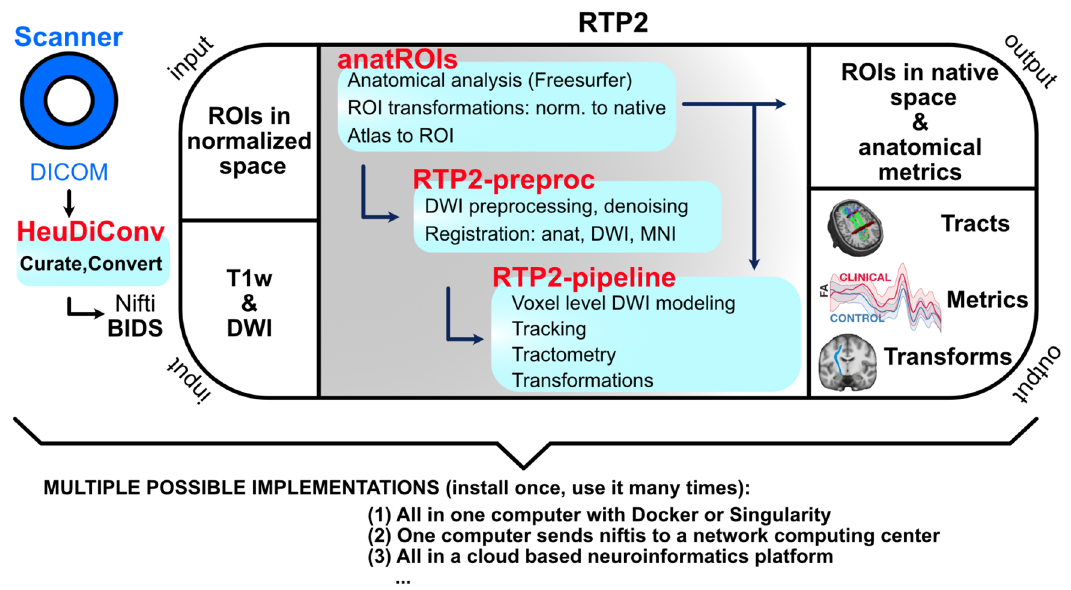
Figure 1. Automated and reproducible pipeline for tractography. RTP2 can be automated to produce reproducible results with minimal human interaction. The DICOMs acquired from the MRI scanner are automatically converted into BIDS format Nifti-s and transferred to the informatics platform. Containerized images containing the anatomical and DWI analysis tools along with files specifying the computational parameters are stored and managed in the system. The system takes individual-subject space anatomical images, DWI data and ROIs in normalized space that researchers would like to use in subsequent steps and first coregisters them. Then it runs the anatomical pipeline and creates structural segmentations and ROIs with Freesurfer, as well as multiple anatomical metrics. The system converts multiple public atlases as well as MNI/ surface defined ROIs into volumetric ROIs to be used later in tractography. After the DWI preprocessing, the user can select any combinations of ROIs to define white matter tracts. Tracts can be defined using seed and target ROIs, or can be selected from all the fibers of a whole-brain tractogram (WBT). In the output of the pipeline the user will obtain all the requested tracts and metrics, including along-the-tract profiles (see Fig. 5). All structural metrics from Freesurfer as well as all the ROIs in individual-subject space generated from the atlases or input by the researcher will be available. Those ROIs can be used for other analyses, such as fMRI. The whole system can be installed once on a single computer, installed in a distributed system working with high performance computing clusters, or managed in a cloud-based neuroinformatic